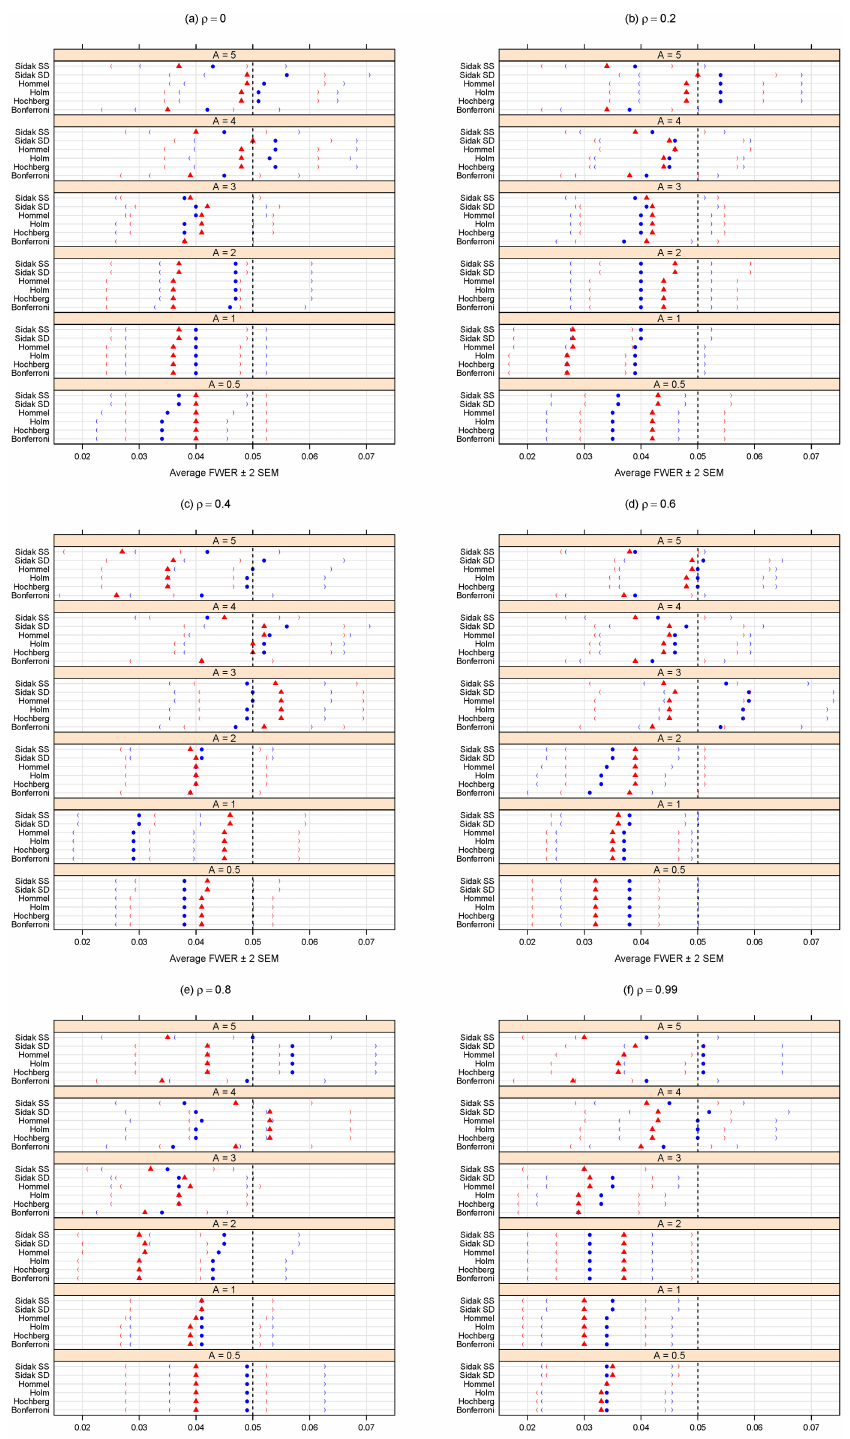
Fig 1. Average FWER for different methods purporting to control the FWER at α = 0.05. A can be thought of as the magnitude of differential abundancefor truly differentiallyabundantfeatures, and ρ is the true correlationwithin blocks of dependent tests. The blue solid circles represent the case of 18 dependent tests (out of 100 total), whereasthe red solid trianglesare for the case of 36 dependent tests. Parentheses indicate ± 2